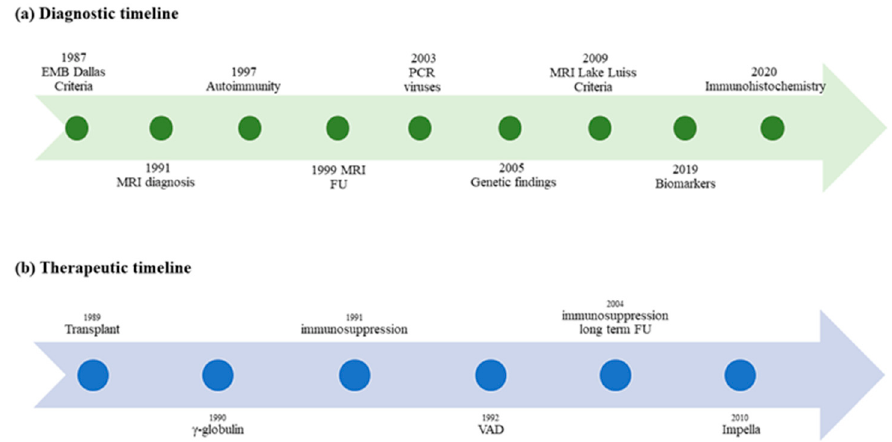
Figure 2. Timelines of milestones in diagnosis and therapy of myocarditis in children. ( a ) Milestones of diagnosis in pediatric myocarditis over time; ( b ) Evidence of therapy in children with myocarditis: the therapeutic approach is not supported by specific pediatric clinical trials.